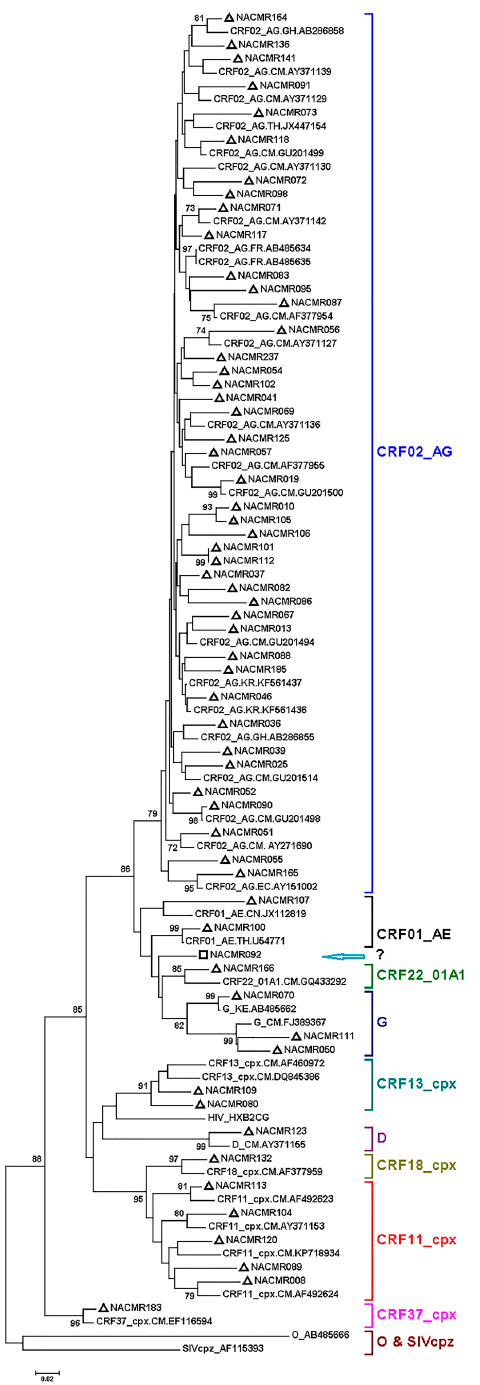
Figure 1. Phylogenetic analysis of Cameroon HIV-1 Tat sequences. Tat exon-1 nucleotide sequences of 60 clinical HIV-1 isolates from Cameroon (NACMR IDs) were aligned using Clustal.W, and phylogenetic analysis performed using the neighbor-joining method and MEGA.5 software as described in the Methods Section. The reference sequences were from the Los Alamos database, and included HIV-1 isolates from eight countries (Cameroon, Ghana, Kenya, France, China, Thailand, Korea, and Ecuador); some references have been omitted to enable better visualization of the new Cameroon sequences (marked by “ ∆ ”). The Bootstrap value of 1000 replicates of at least 70% was used to determine the HIV-1 subtype. Subject NACMR092 was infected with recombinant HIV-1 CRF01_AE/CRF22_01A1 (“ ”, blue arrow). The scale bar represents 2% genetic distance.